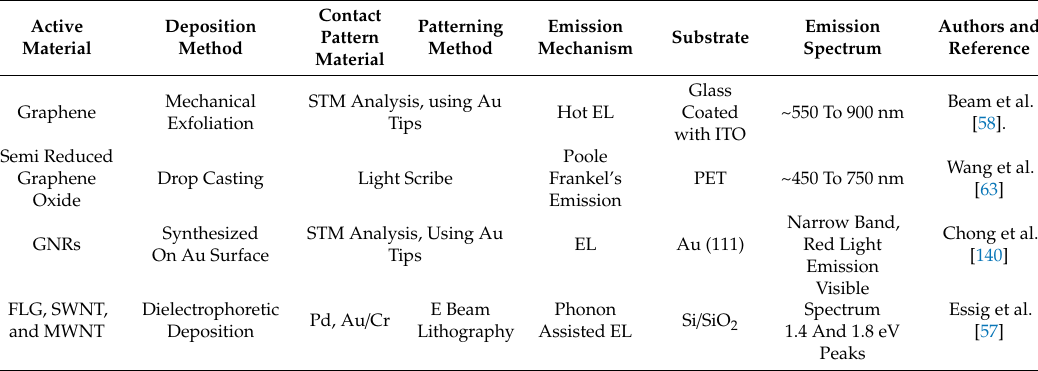
Figure 13. ( a ) and ( b ) show the phonon-assisted electroluminescence spectra from SWNT, with diameter from 0.94 to 1.49, ( c ) the relation between phone flux and biased voltage has been demonstrated, where the blue and red sign present relative peaks of low and high energy emissions. ( d ) The phonon dispersion along Γ -K direction and Brillouin zone with its symmetry point M, K, and Γ . The momentum for the electronic transition from M to K (red arrow) provided by phonons in the Γ -K direction (blue line). In the relevant momentum range (red dashes), phonons of the L O branch have energy consistent with that required to explain the electroluminescence data [57]. Table 3. The summary of electroluminescence (EL) emissions.